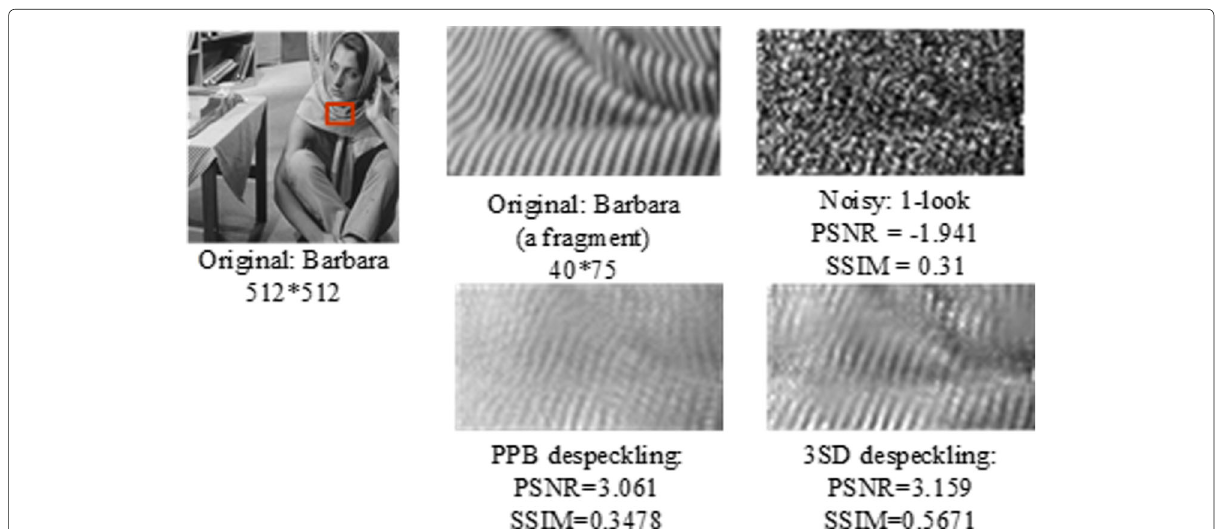
Fig. 6 SAR image despeckling comparing the proposed 3SD method with the PPB